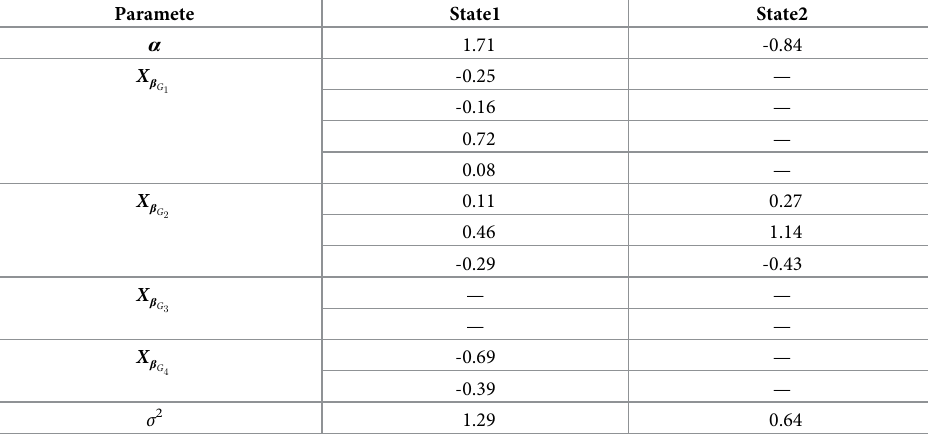
Table 6. Estimate results of Alzheimer’s disease